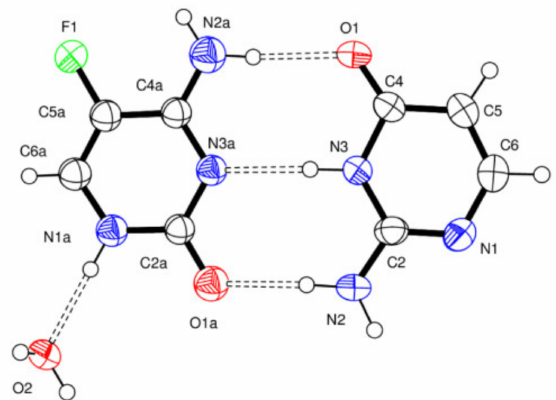
Figure 2. The asymmetric unit of (I), showing the adopted atom-numbering scheme. Displacement ellipsoids are at the 50% probability level. The asymmetric unit was selected so that the nucleobase molecules were linked by triple hydrogen bonds. H atoms are shown as small spheres of arbitrary radii. Hydrogen bonding is indicated by dashed